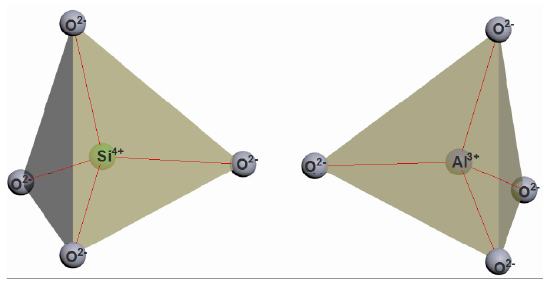
Figure 2. TO 4 tetrahedra [compiled by the authors].